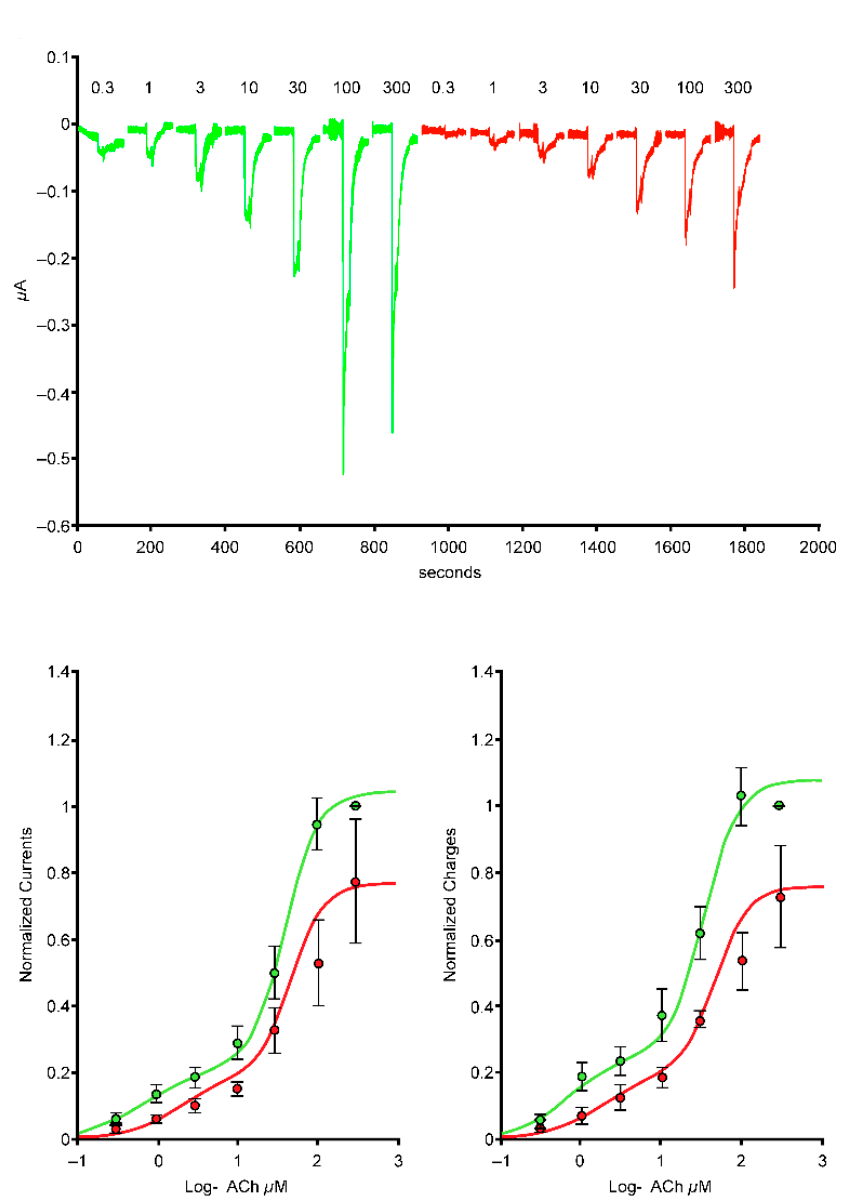
Figure 2. Effects of the spike protein containing the receptor-binding domain (Spike-RBD) protein at the concentration-response curve to acetylcholine (ACh) of the α 4 α 6 β 2 nicotinic acetylcholine receptor complementary DNA. Typical currents were recorded in the same cell before (green traces) and during exposure to 1 µg/mL of the Spike-RBD protein (red traces). Currents were elicited by brief exposure to ACh test pulses with a series of concentrations. Currents were normalized to unity vs. the maximal value and average results obtained in five cells were plotted vs. the logarithm (log) of the ACh concentration. The green curve is the best fit obtained with the Hill equation. Areas under the curve are plotted on the lower right-hand side.